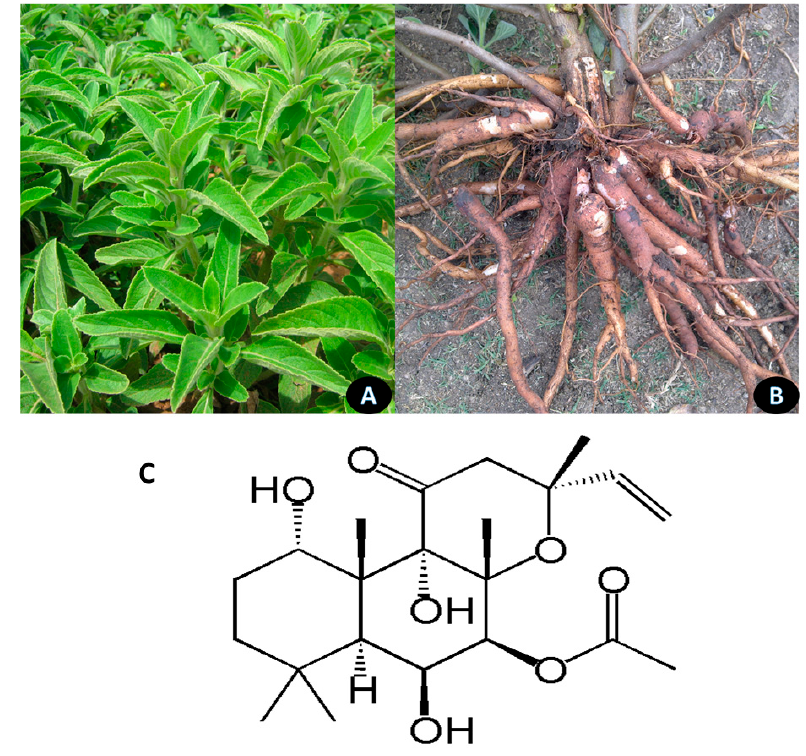
Figure 3. Coleus forskohlii . ( A ) leaves; ( B ) roots; ( C ) Forskolin. Several clinical and pre-clinical studies report the effect of forskolin in promoting lean body mass and decreasing body fat. In one of the earlier clinical studies, fourteen overweight volunteers, were administered forskolin at a dose of 125 mg twice a day for 12 weeks. The total body weight and body fat decreased significantly, and BMI improved at the end of the study [77]. In an 8 week open labelled study, 6 overweight, women receiving 500 mg of the C. forskohlii extract, equivalent to 50 mg forskolin per day, showed significant reduction of body weight and fat content and an increase in lean body mass [78]. In 41 obese patients administered with forskolin along with 250 mg of C. forskohlii extract for 12 weeks, body weight differences were not significant, but changes in hip and waist circumference were significant, suggesting a decrease in fat mass and an increase in bone mass [79]. Similar results were observed in other randomized trials in obese men and women [80–82]. Mechanism of action: Forskolin increases the production of Hormone ‐ sensitive lipase (HSL) by the action of cAMP. HSL releases stored triglycerides for metabolic consump ‐ tion, thus reducing fat storage [83]. The increased cAMP activates the downstream protein kinase A. This cAMP/PKA dependent pathway leads to the overexpression of UCP1, the protein involved in adipocyte browning. PKA activates the p38 mitogen ‐ activated protein kinase (MAPK), which stimulates the expression of the PPAR γ coactivator ‐ 1 α (PGC ‐ 1 α ) and the activating transcription factor 2 increasing UCP1 expression. Alternately, cAMP response element binding protein directly binds on UCP1 promoter in a p38 MAPK ‐ inde ‐ pendent manner to induce UCP1 expression [84]. Forskolin also activates AMPK by phos ‐ phorylating the tyrosine ‐ 172 residue, required for lipolysis activity [85].